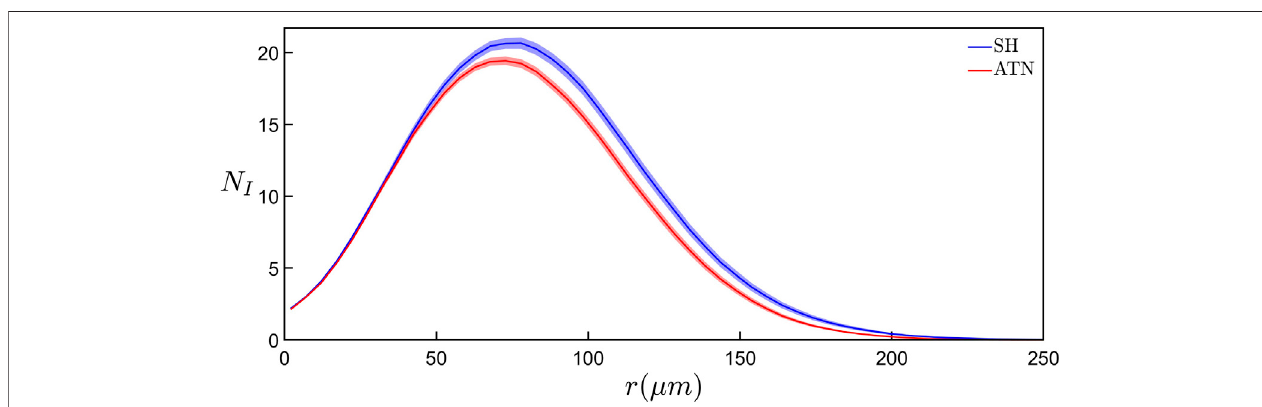
FIGURE 2 | Comparison of the results of modi fi ed Sholl analyses showing the average number of intersections of dendrites, N I , with a sphere surface of radius r between the basal arbors in the SH (blue curve) and ATN (red curve) categories. Each curve represents the mean behavior across all basal arbors within the corresponding category and the shaded region around each curve shows the standard error from the mean within that category. For r ≥ 78 μ m, the N I values of the SH category are signi fi cantly higher ( p ≤ 0.01) than the ATN category.